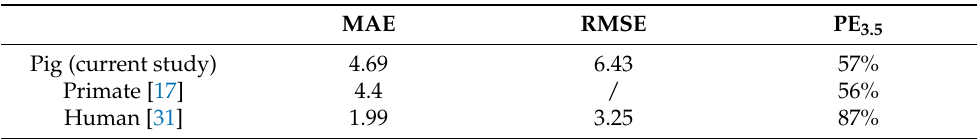
Table 4. Accuracy comparison of different species presented as mean absolute error (MAE), root mean square error (RMSE) and percentage of HR error below 3.5 beats per minute (bpm) when compared to the gold